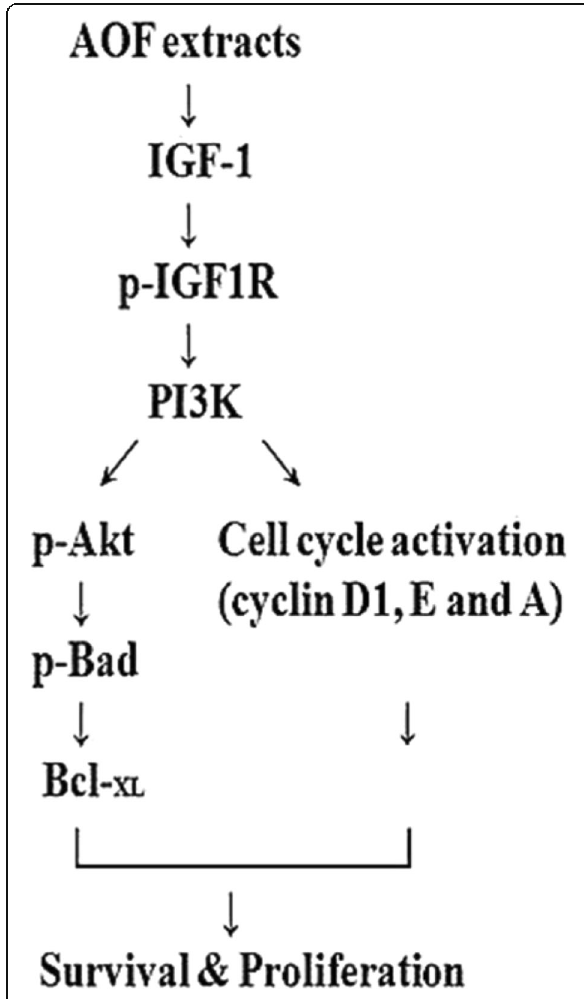
Fig. 7 Schematic model of the survival and proliferative effects of AOF extract on RSC96 Schwann cell. Stimulation of Schwann cell with AOF extract activate IGF-I signaling, leading to upregulation of the PI3K/Akt pathway and activation of the cell cycle regulatory proteins cyclin D1, E and A, resulting in the survival and proliferation of RSC96 Schwann